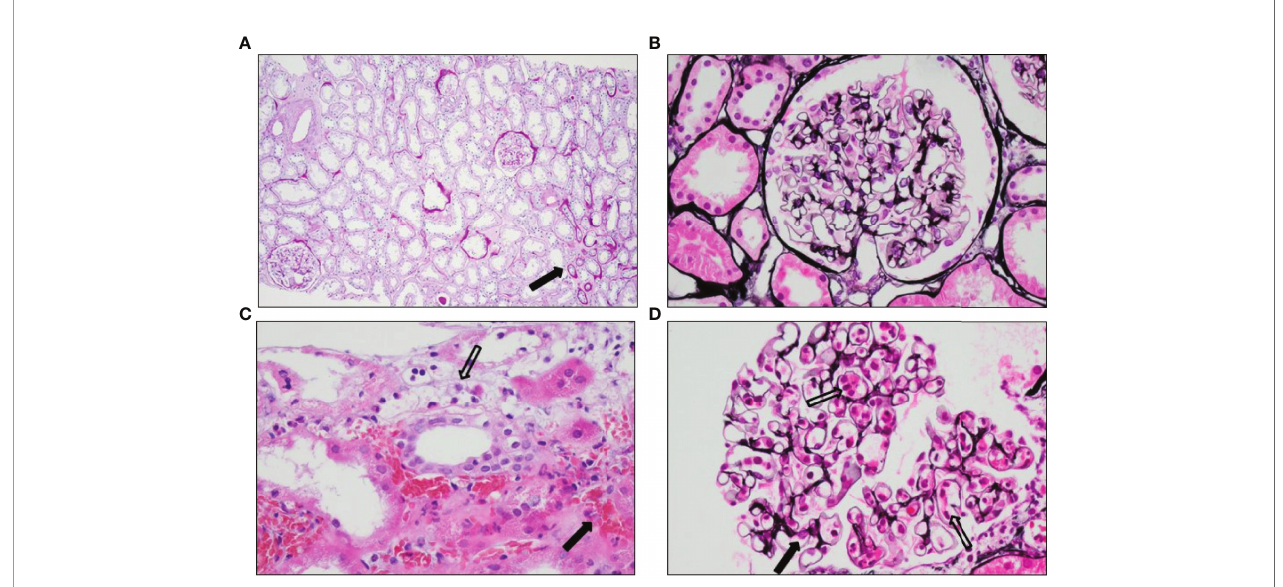
FIGURE 2 | Histology of the pre- and post-implantation biopsies. (A) PAS staining showing no pre-existent damage apart from <5% atrophy (arrow) seen as broadened tubular basement membranes, fi brosis, and smaller tubuli in the preimplantation biopsy. (B) Jones ’ methenamine silver staining showing a normal glomerulus in the preimplantation biopsy. (C) Hematoxylin and eosin staining showing hemorrhagic areas outside the vascular bed (black arrow) and in fl ammatory cells with destruction of endothelial cells (open arrow) in the posttransplantation biopsy. (D) Jones ’ methenamine silver staining showing slightly expanded glomerular capillaries with abundant in fl ammatory cells (open arrows) and somewhat pronounced endothelial cells (black arrow) in the posttransplantation biopsy.